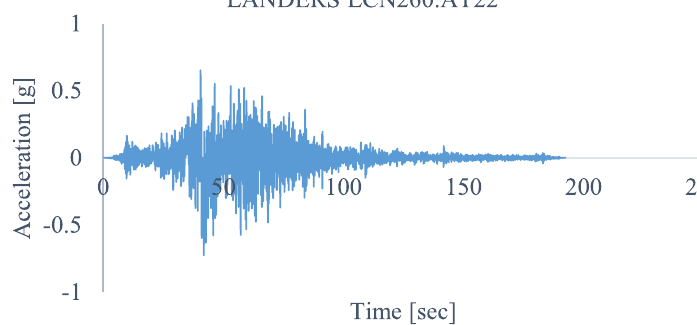
Fig. 10 The record of the horizontal component (LCN260) of the Landers earthquake